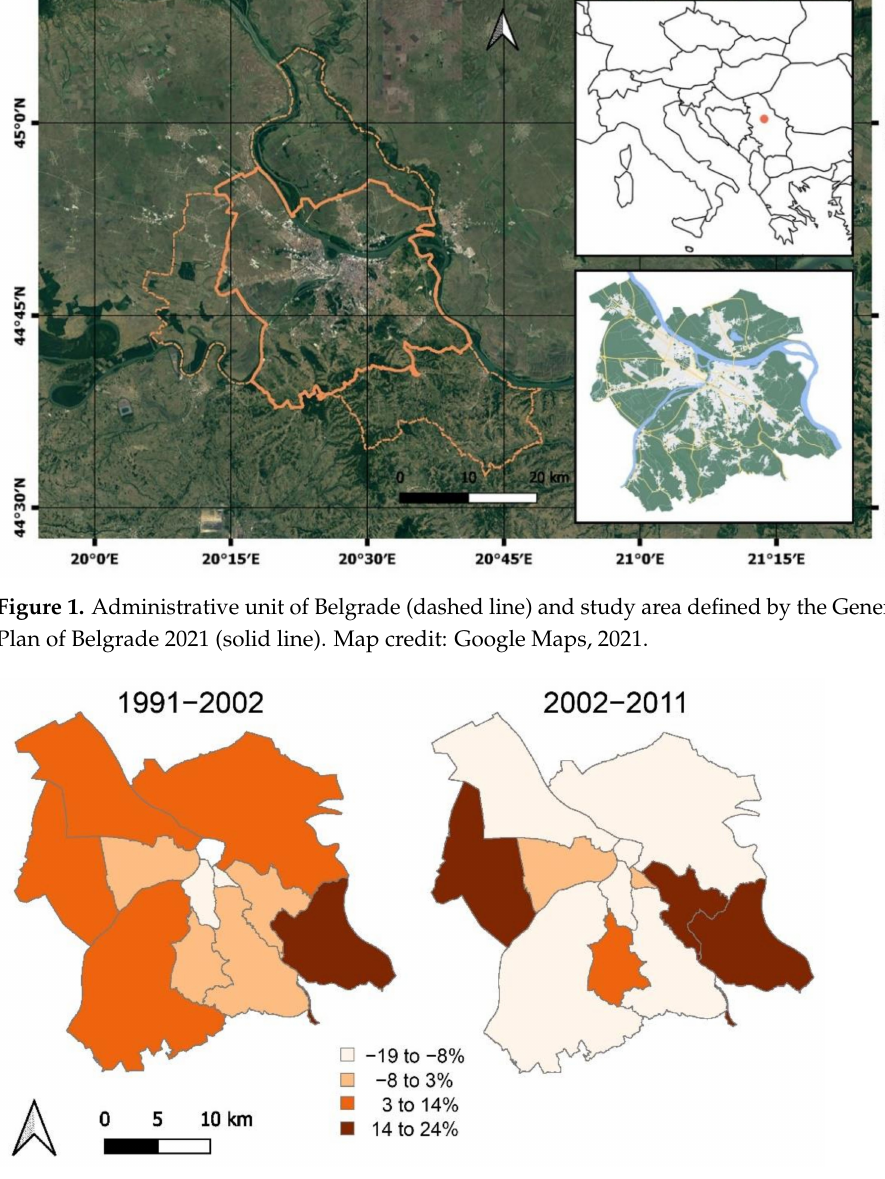
Figure 2. Changes in population density for 12 municipalities, according to censuses from 1991, 2002 and